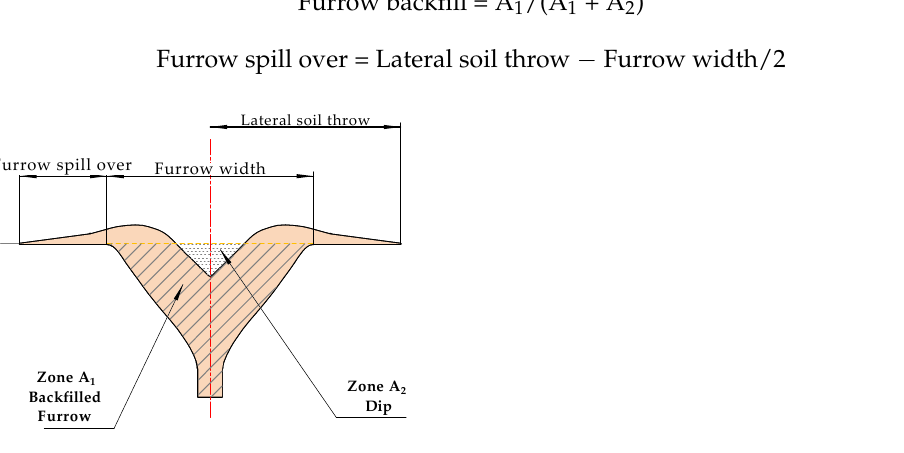
Figure 9. Furrow profile parameters.